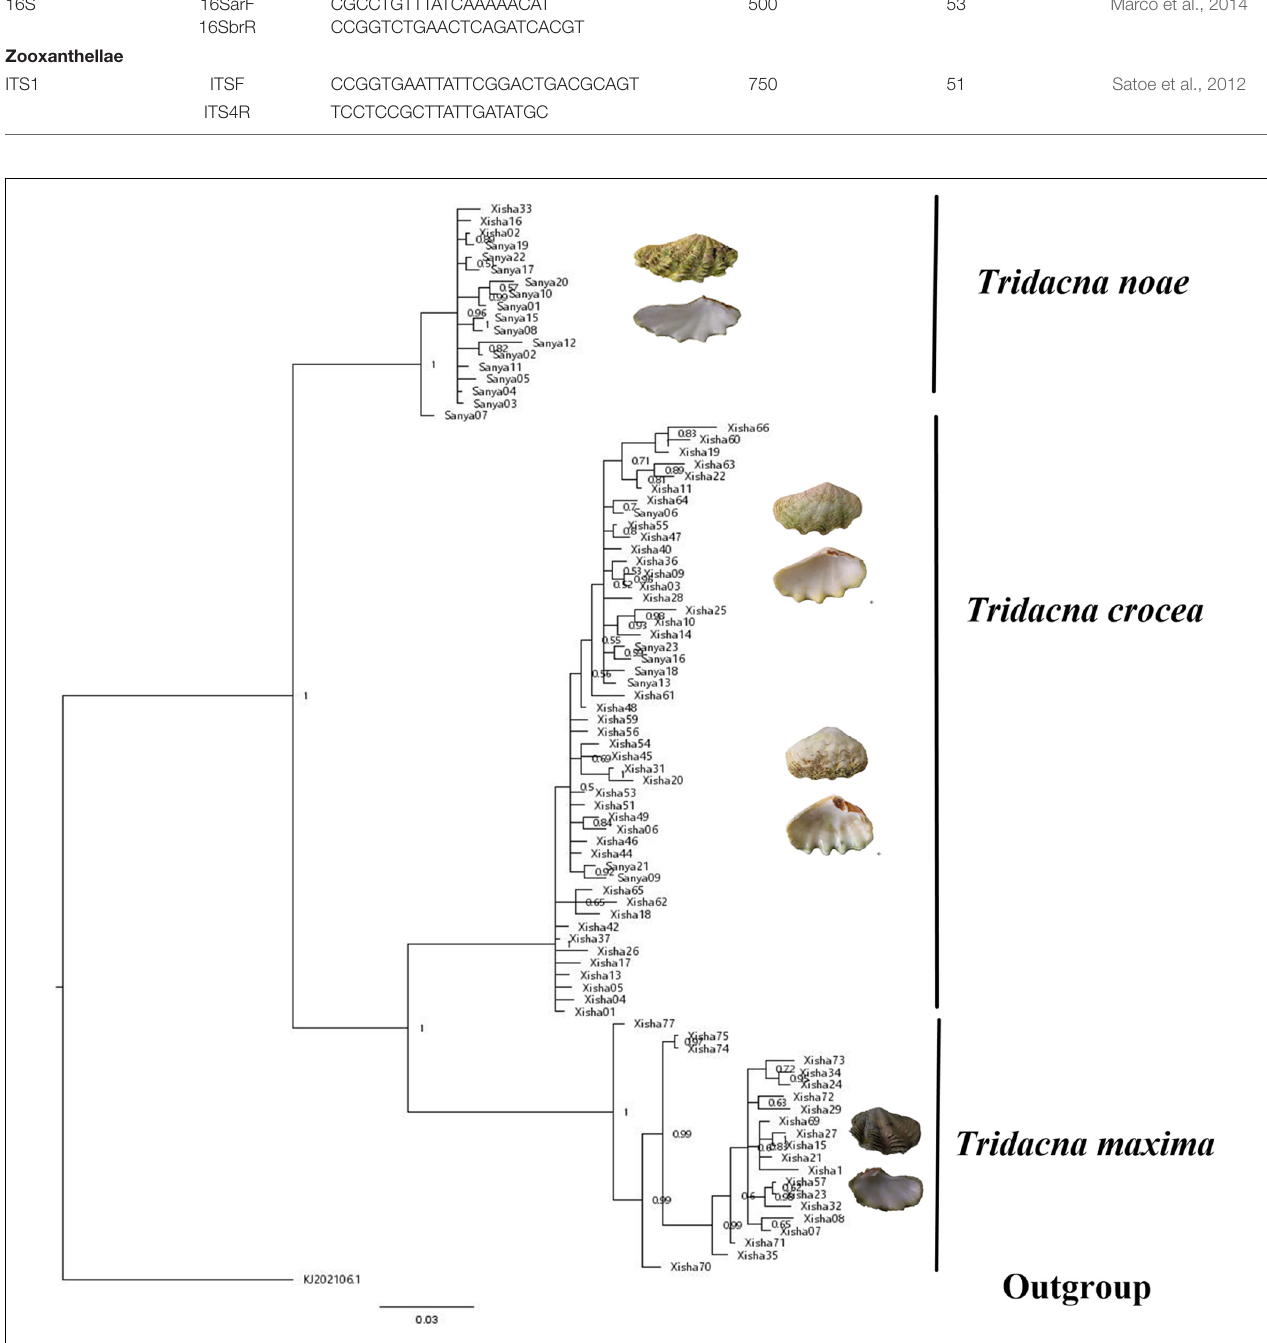
FIGURE 1 | Binary indexed tree of the three giant clams based on the COI fragment. Hippopus hippopus (KJ202106) was used as outgroup. Numbers at nodes are posterior probabilities.